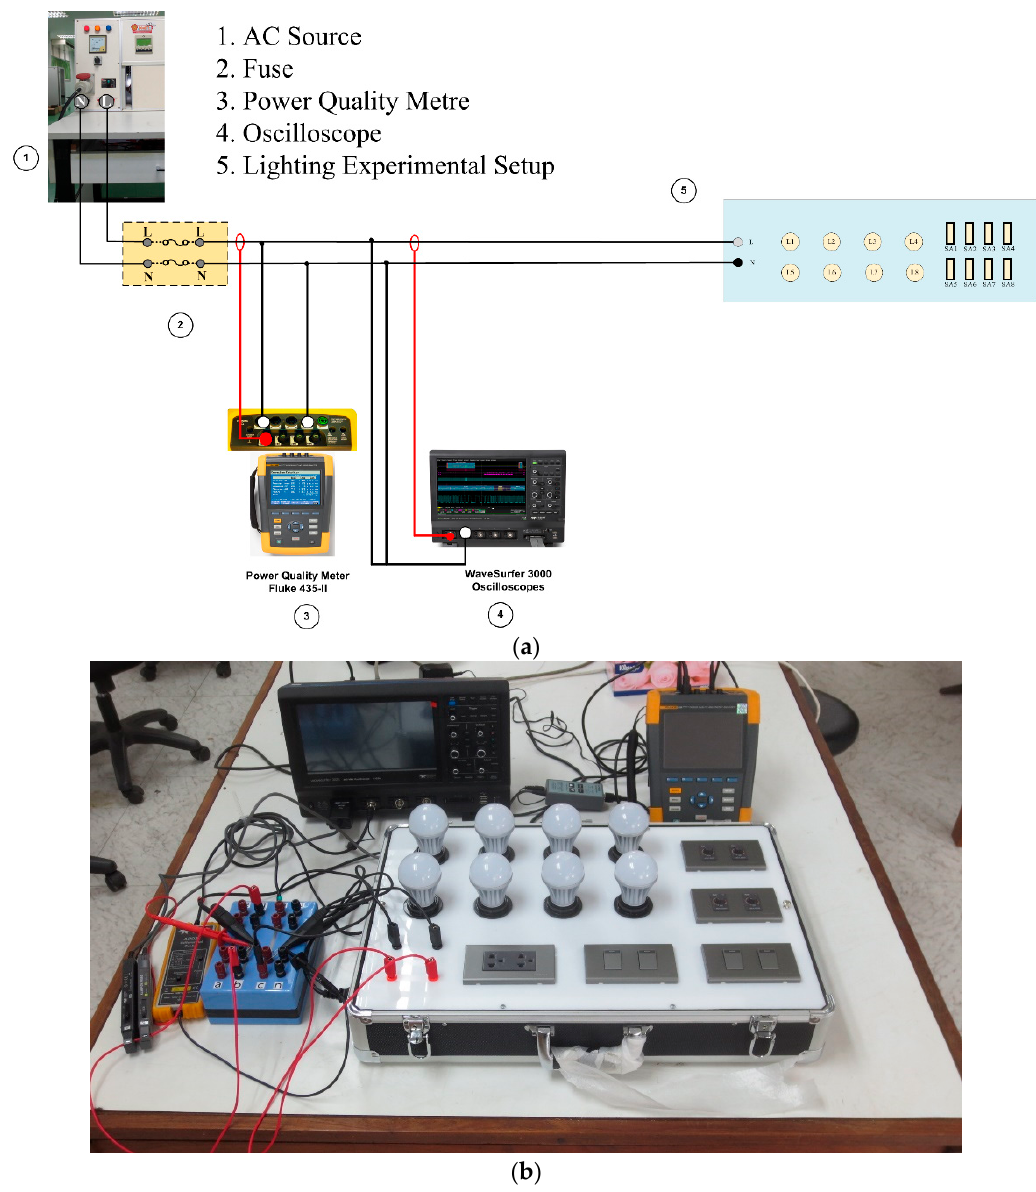
Figure 9. Experimental setup in the case of LED lamp light bulb type. ( a ) Single line diagram of experimental setup; ( b ) Overall experimental setup.